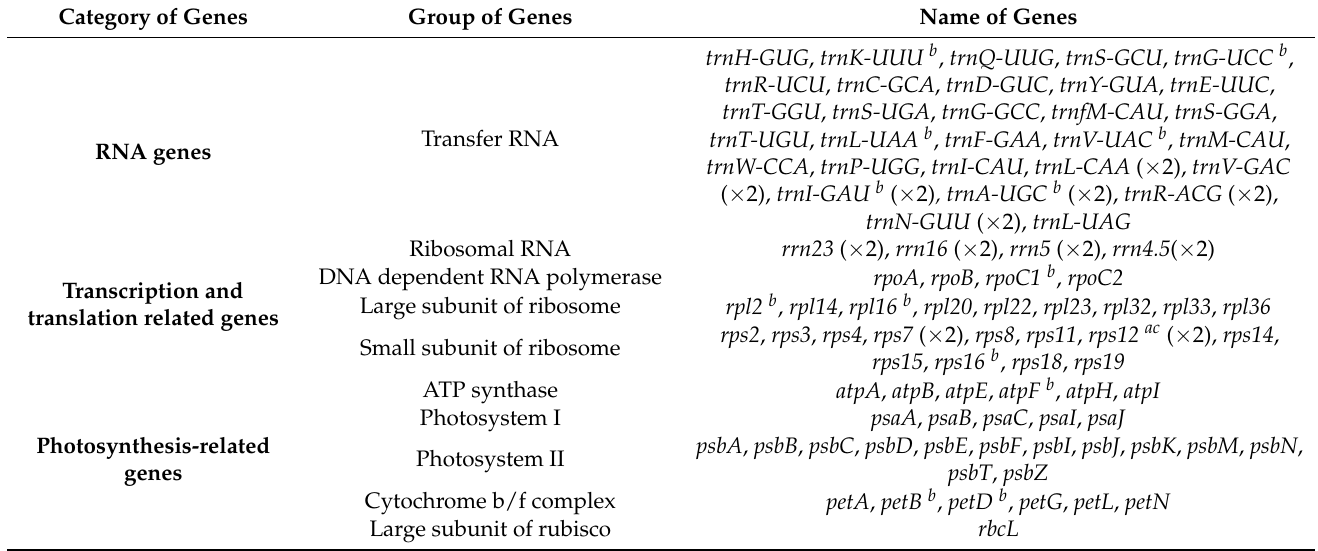
Figure 2. GC content of the M. chuanchienensis . This map was created using the web program GCView Server. The black portion represents changes in GC content in different regions of the genome. The deviation of G and C content in each single strand is called GC skew. The specific calculation method is (nG − nC)/(nG + nC), so GC skew + (green portion) means that the content of G is greater than that of C, and GC skew − (magenta portion) means that the content of G is less than that of C. Table 1. Genes found in the assembled M. chuanchienensis chloroplast